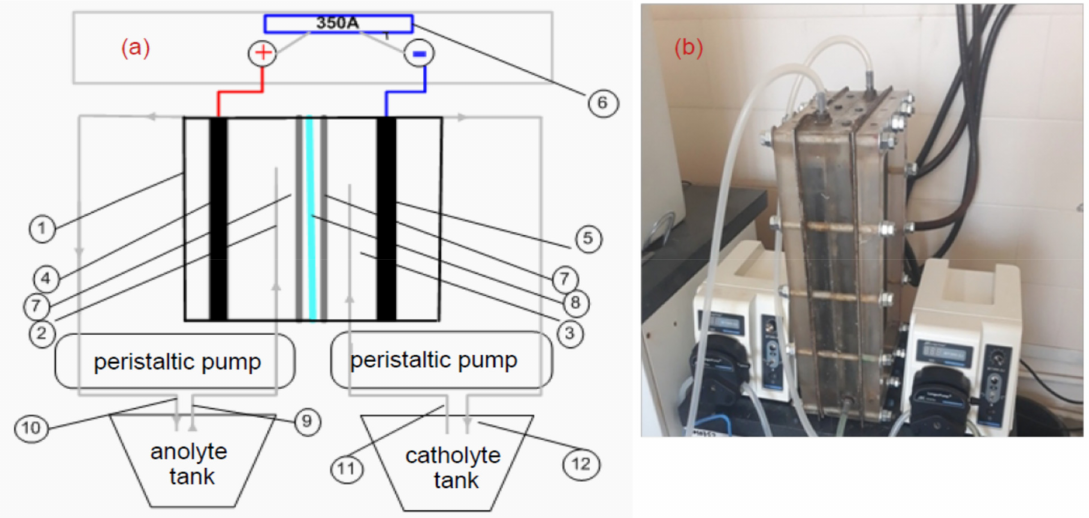
Figure 2. Scheme ( a ) and general view of the laboratory ( b ) installation of the membrane. Electrolyzer. 1—cell body; 2—cathode chamber; 3—anode chamber; 4—anode (lead + 1 % silver); 5—cathode (steel plate); 6—power supply; 7—perforated partitions for fixing the membrane; 8—anion-exchange membrane; 9—branch pipe for introducing the solution into the anode chamber; 10—branch pipe for removing the solution from the anode chamber; 11—branch pipe for introducing the solution into the cathode chamber; 12—branch pipe for removing the solution from the cathode